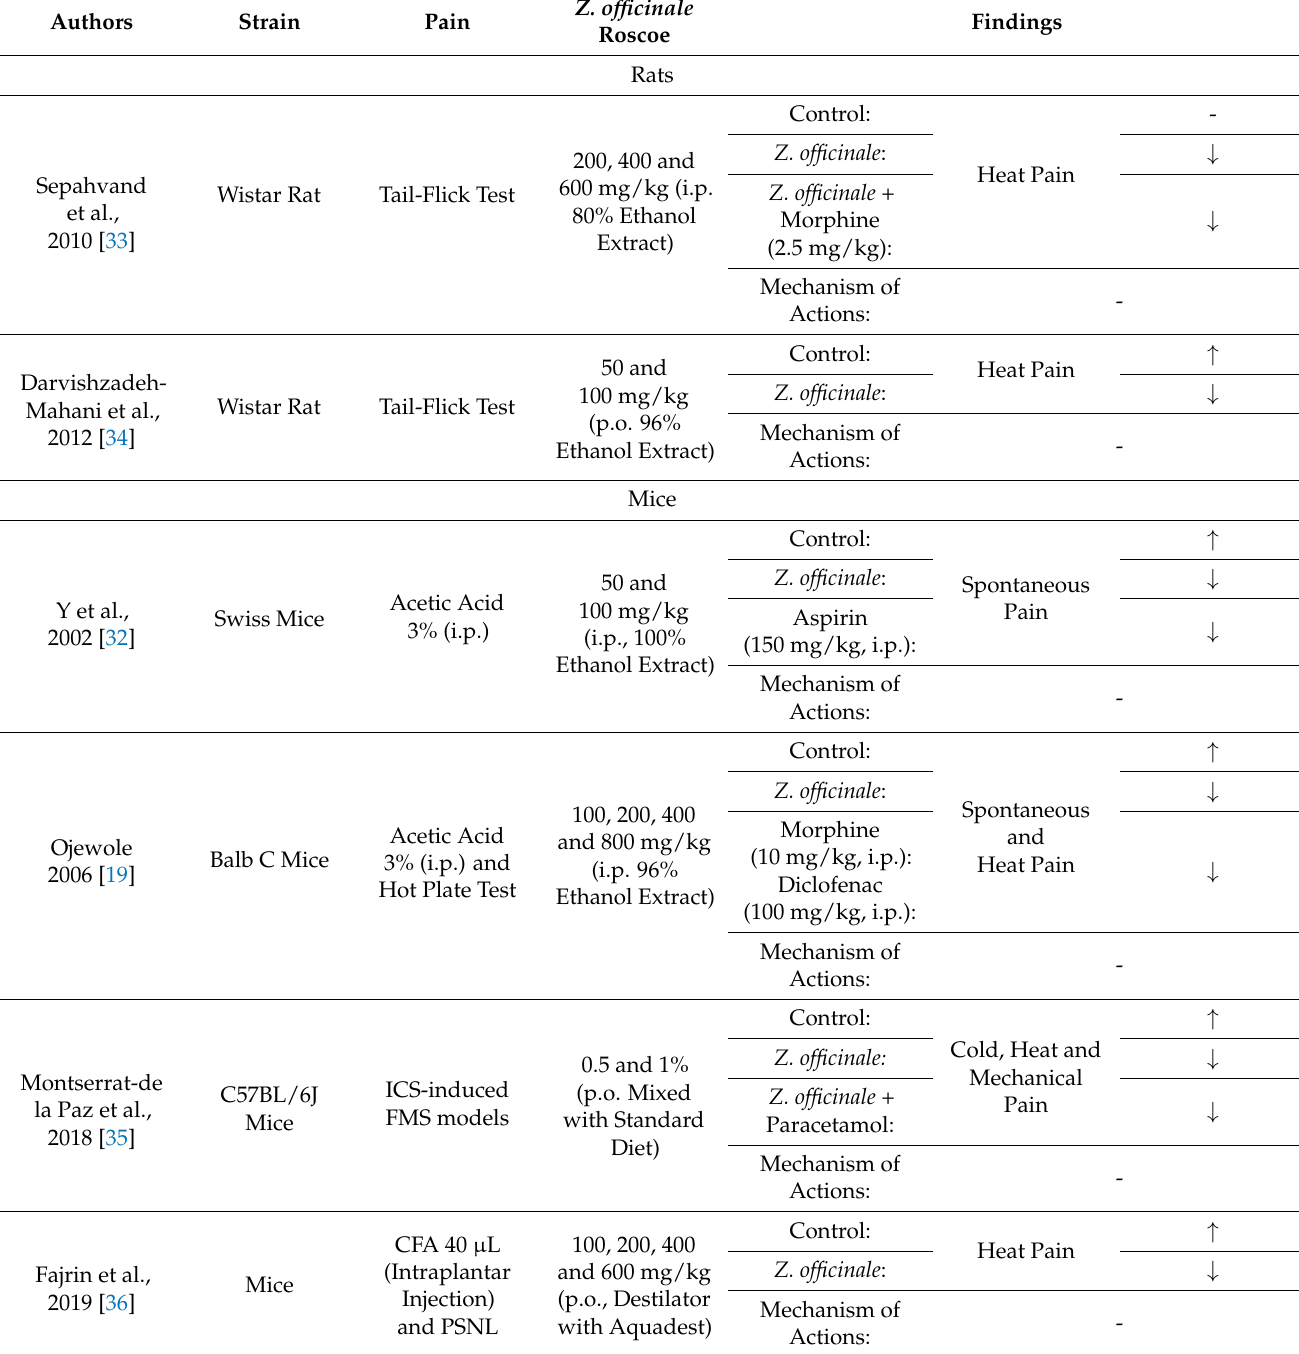
Table 1. Summary on the effect of Z. officinale on